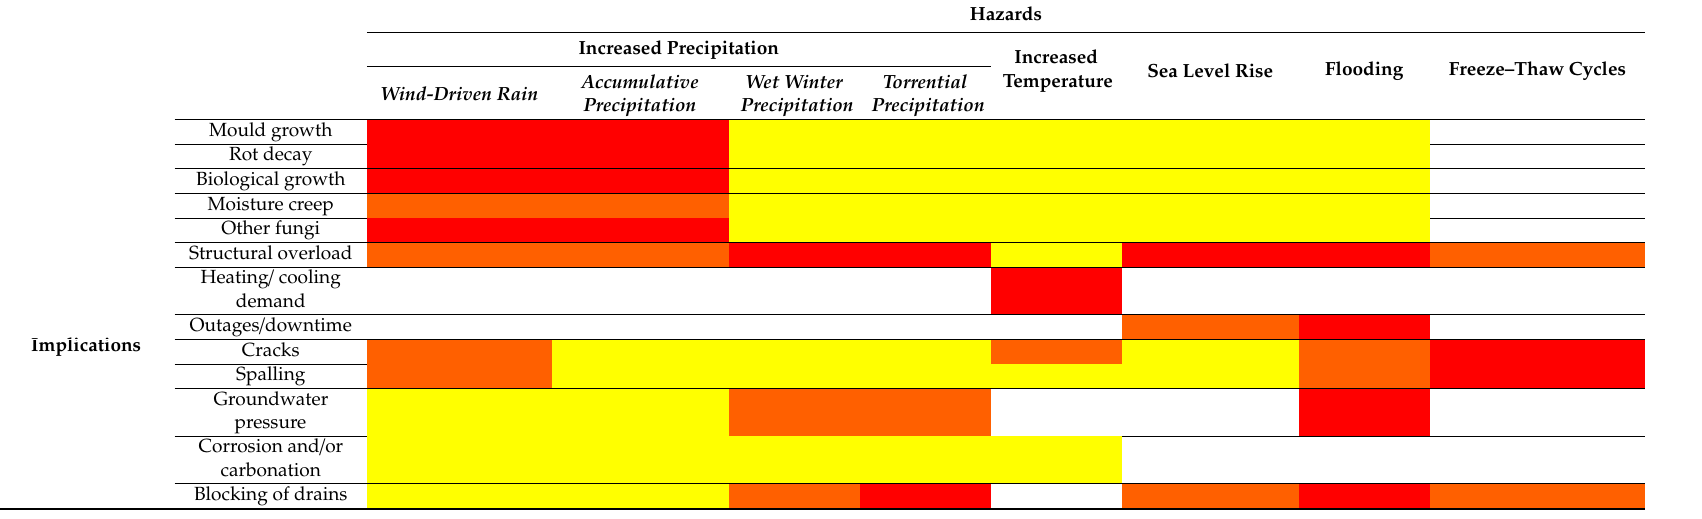
Table 7. Overview of potential hazards in response to anticipated climatic stimuli and their implications. Red shading indicates a high degree of influence and white very low or no